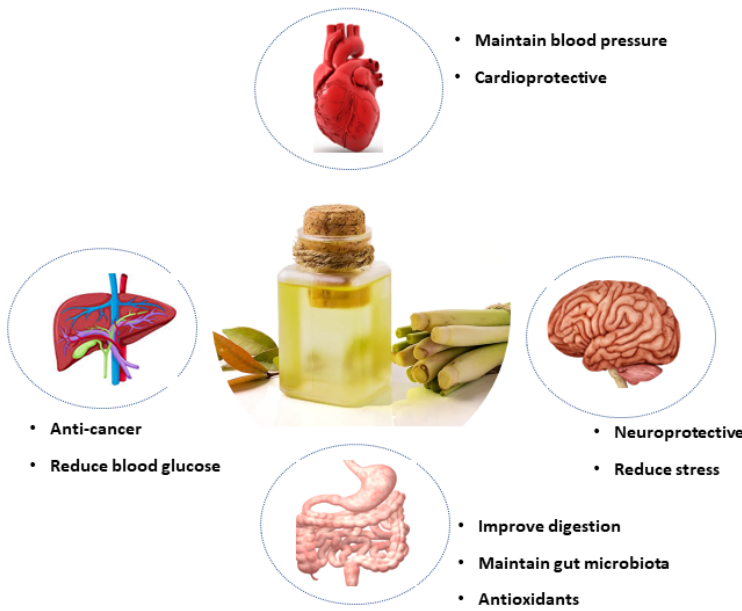
Figure 4. Potential applications of lemongrass.